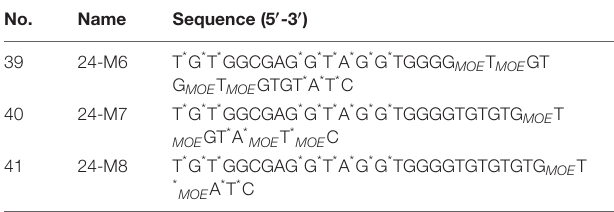
TABLE 1 | The sequences of phosphothioated aptamer BC15-31s.